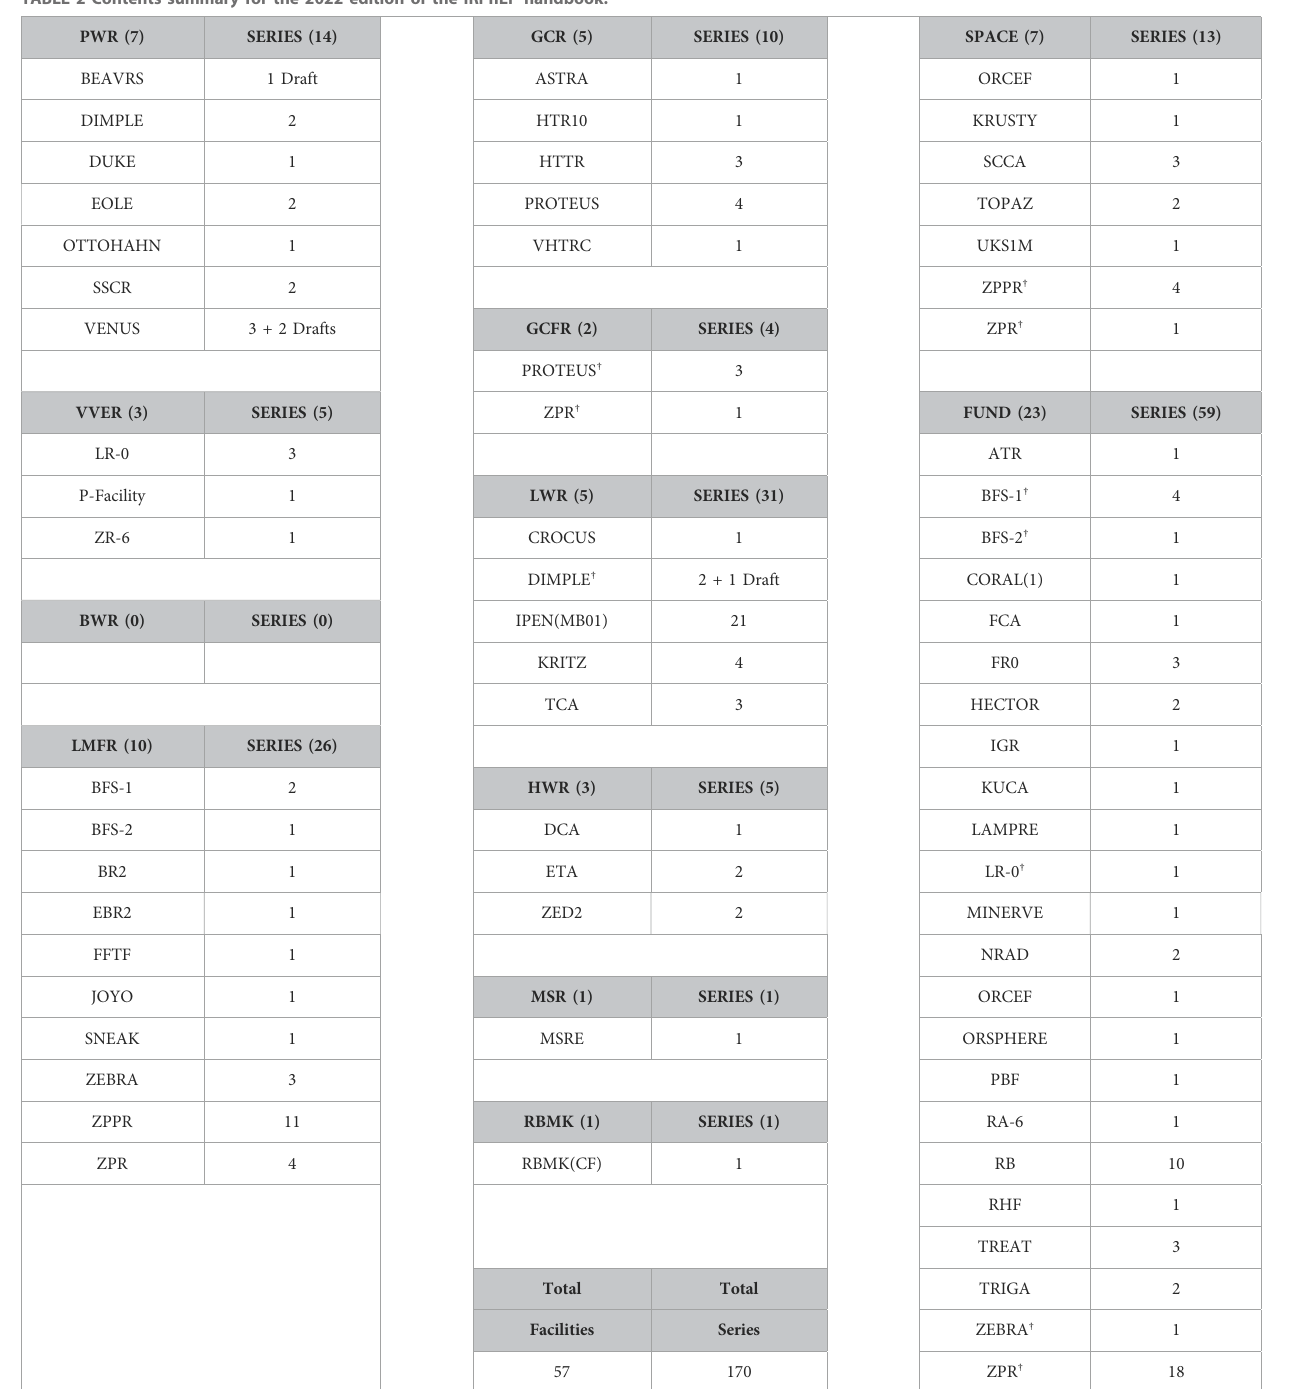
TABLE 2 Contents summary for the 2022 edition of the IRPhEP handbook.